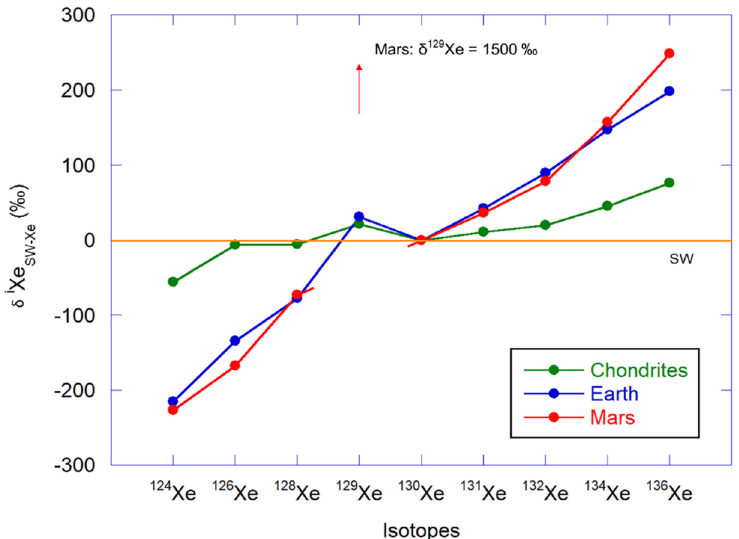
Figure 9. Xe isotopic composition in Earth and Mars atmospheres [resp. ([1–80]), compared to chondritic Xe isotopic compositions [72]. Isotopic compositions are given using the delta notation, normalized to 130 Xe and to solar wind xenon (SW-Xe, orange line), following the formula: δ i Xe SW-Xe =